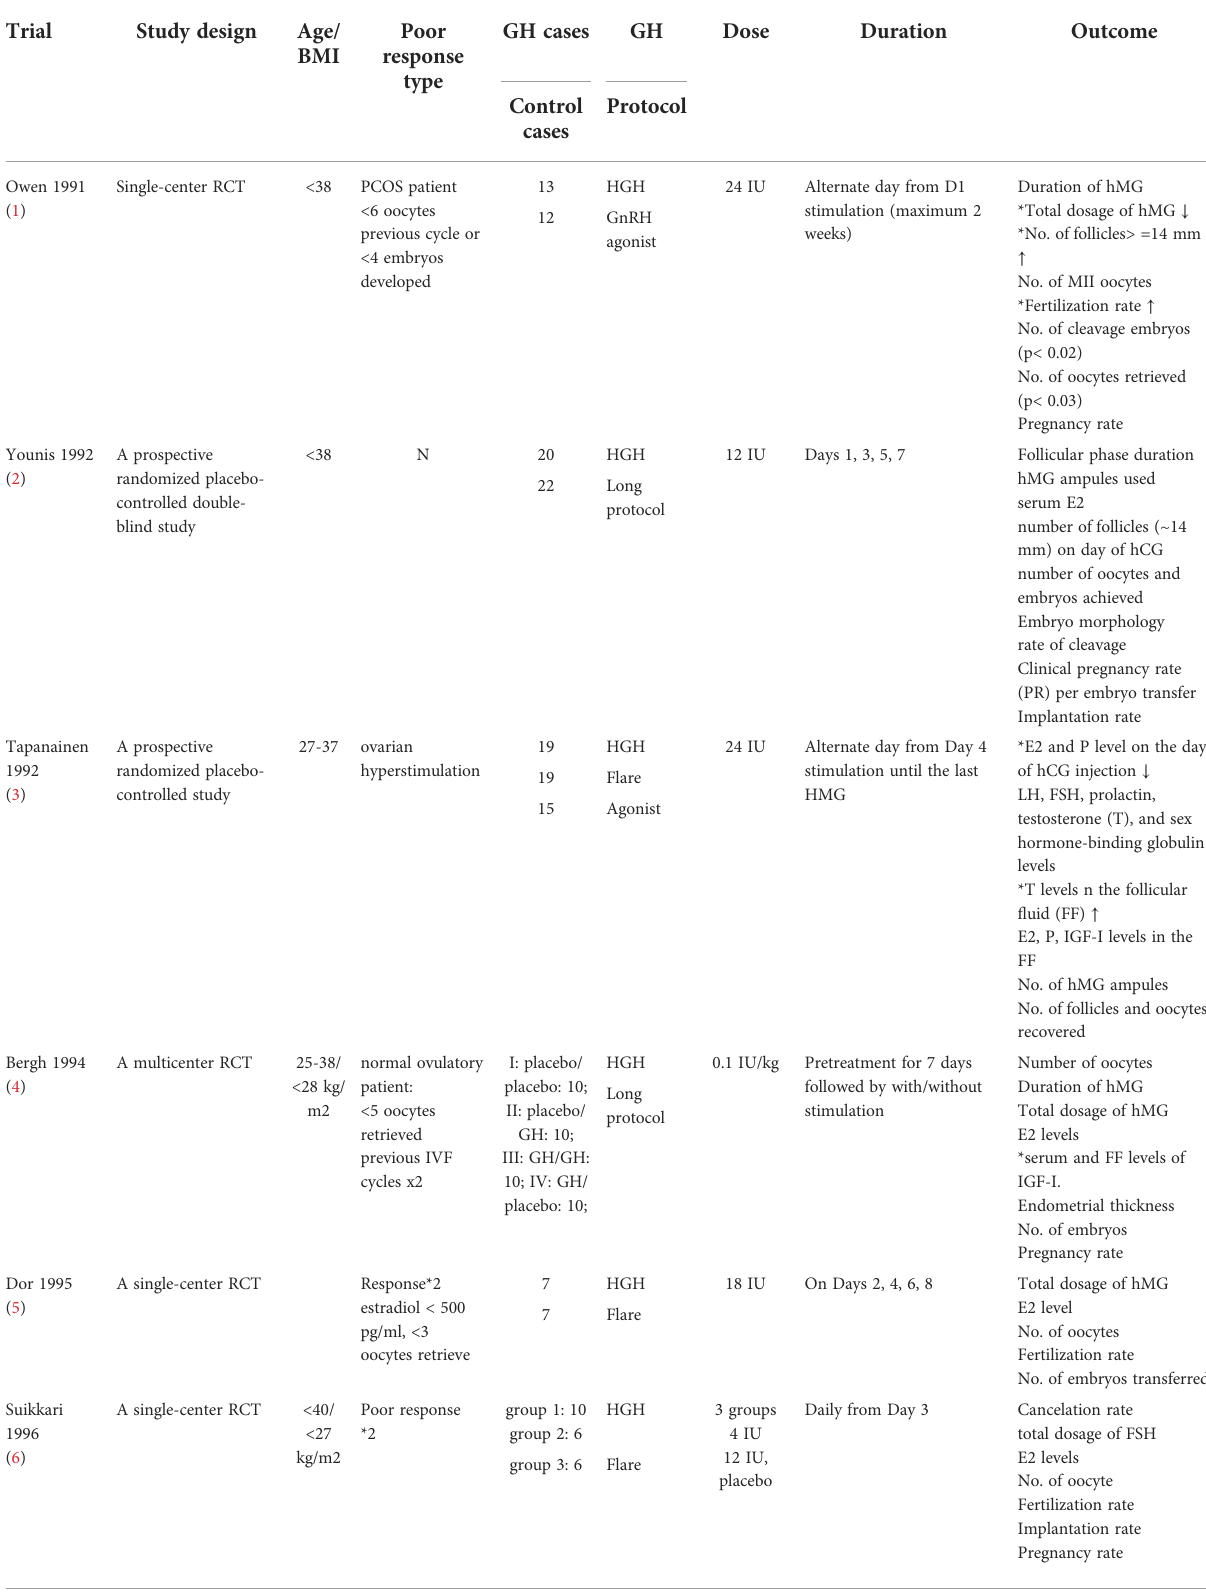
TABLE 1 Studies of randomized control trial using growth hormone in a population of poor ovarian